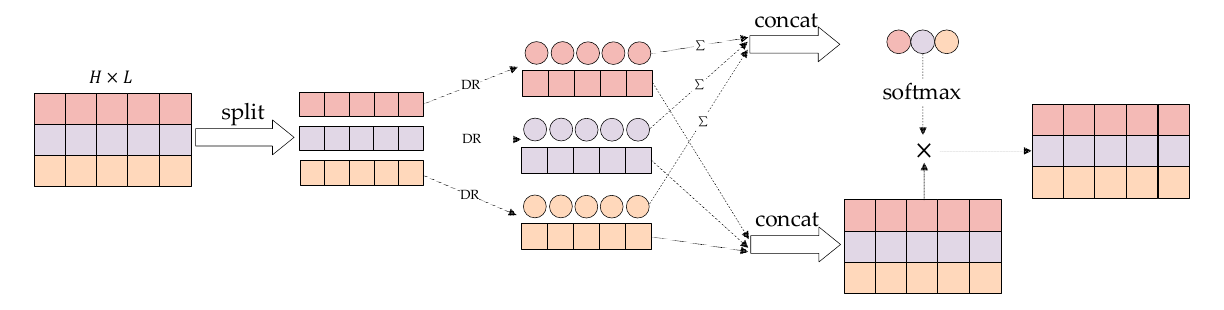
Figure 4. The process of sequence routing.